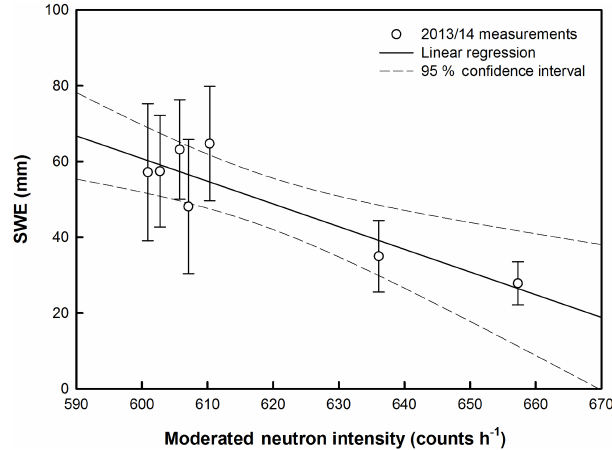
Figure 3. Linear regression of 2013/2014, 2014/2015 with the soil water storage offset (blue), and 2014/2015 with no offset (grey). The red line is the linear regression for 2013/2014. The blue and grey lines represent the linear regressions for the 2014/2015 data with and without the soil water storage offset respectively. Error bars represent standard deviation of SWE.